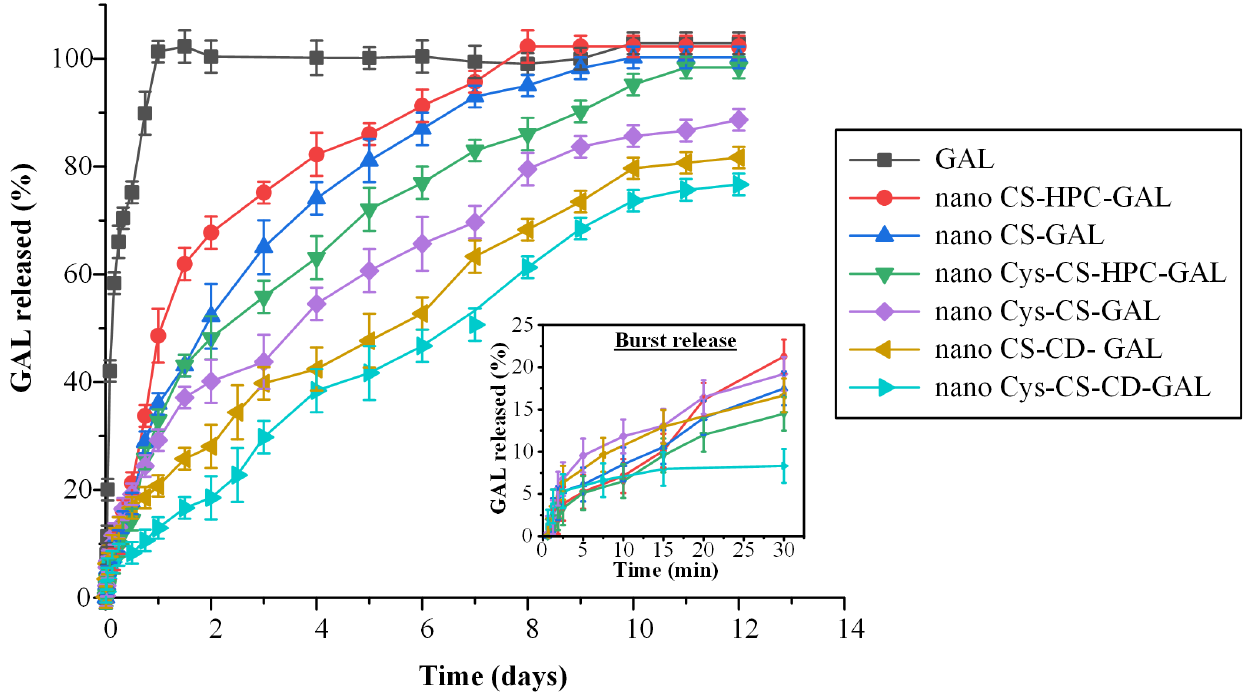
Figure 9. In vitro dissolution profiles of the pure GAL and the prepared